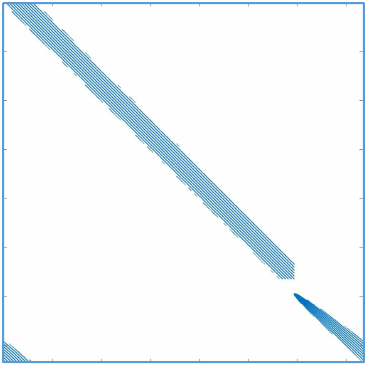
Figure 14. Illustration of the sparse structure of the transform matrix. Blue areas correspond to non-zero coefficients.